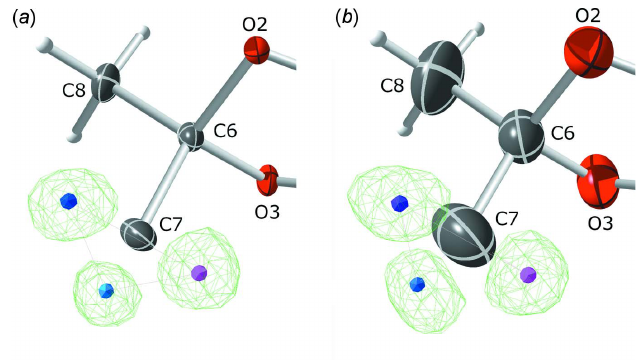
Figure 2 Difference-electron density showing the presence of well-ordered hydrogen atoms at both ( a ) 90 K and ( b ) 298 K for the methyl group at C7. Ellipsoids are drawn at the 50% probability level. Diagram generated using ShelXle (Hu¨bschle et al. , 2011).